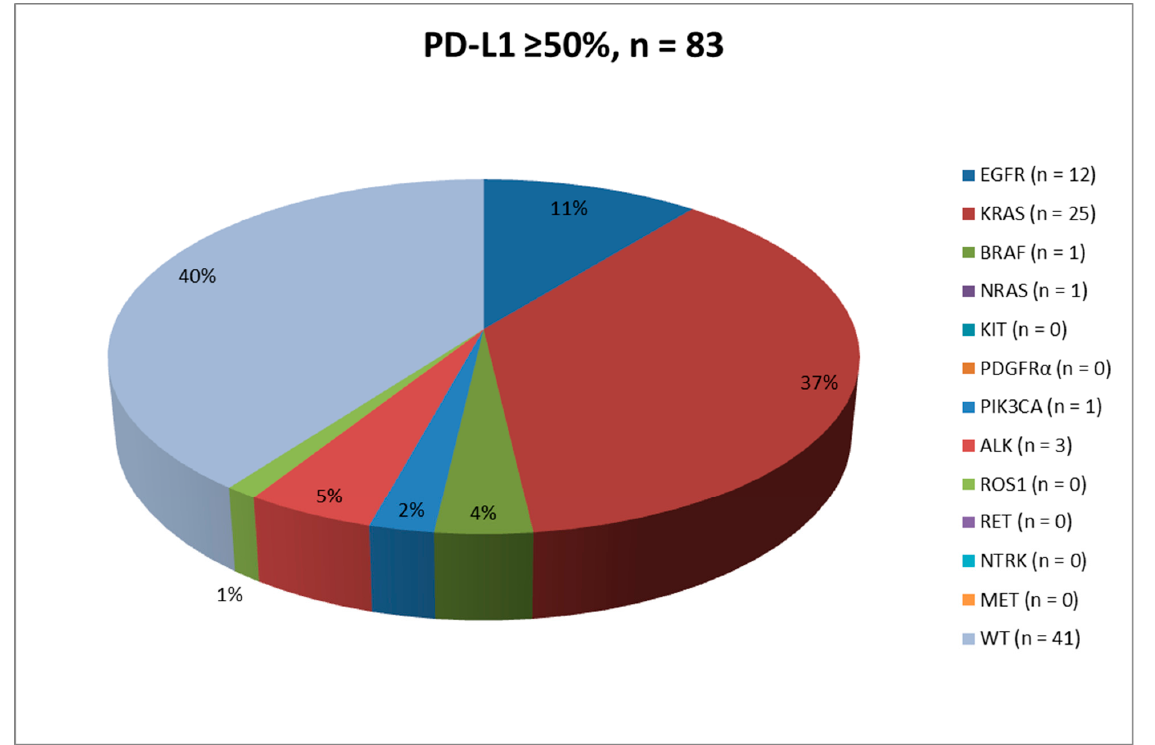
Figure 3. Pie chart describing the mutational landscape in the ≥ 50% PD-L1 positive advanced stage NSCLC patients population.